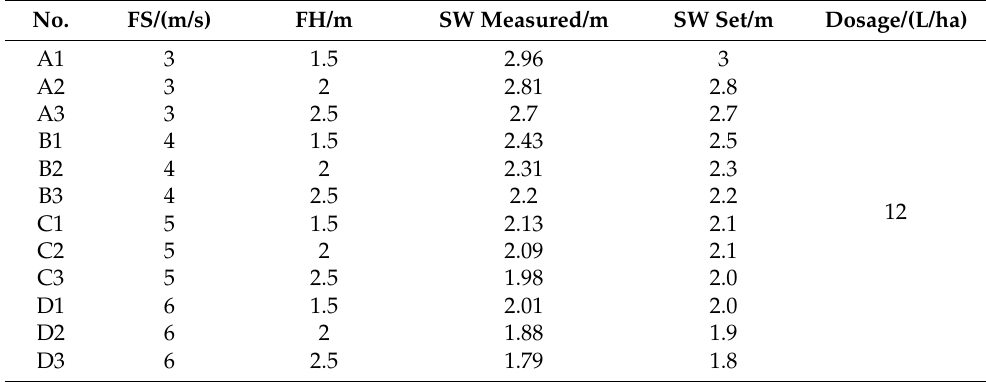
Table 3. Test parameters of P20 UAV.